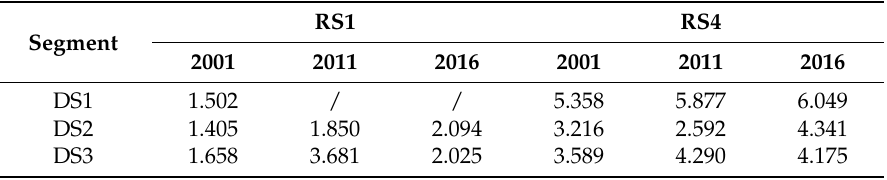
Table 2. Change of BI B in three equal distance segments in RS1 and